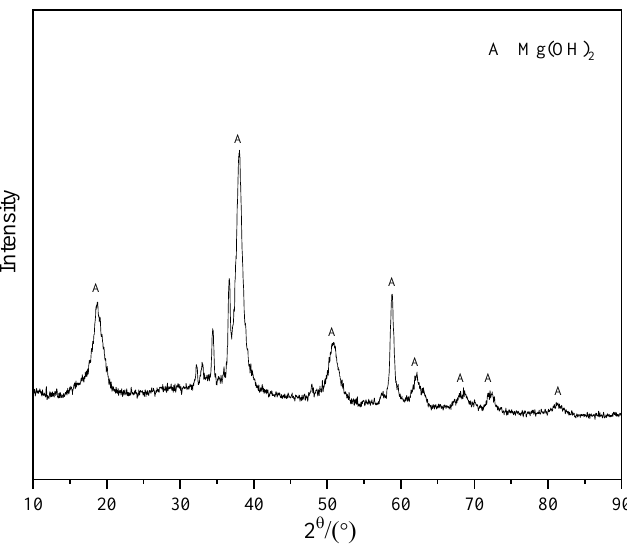
Figure 5. XRD patterns of corrosion products of F-state Mg-2Nd alloy.